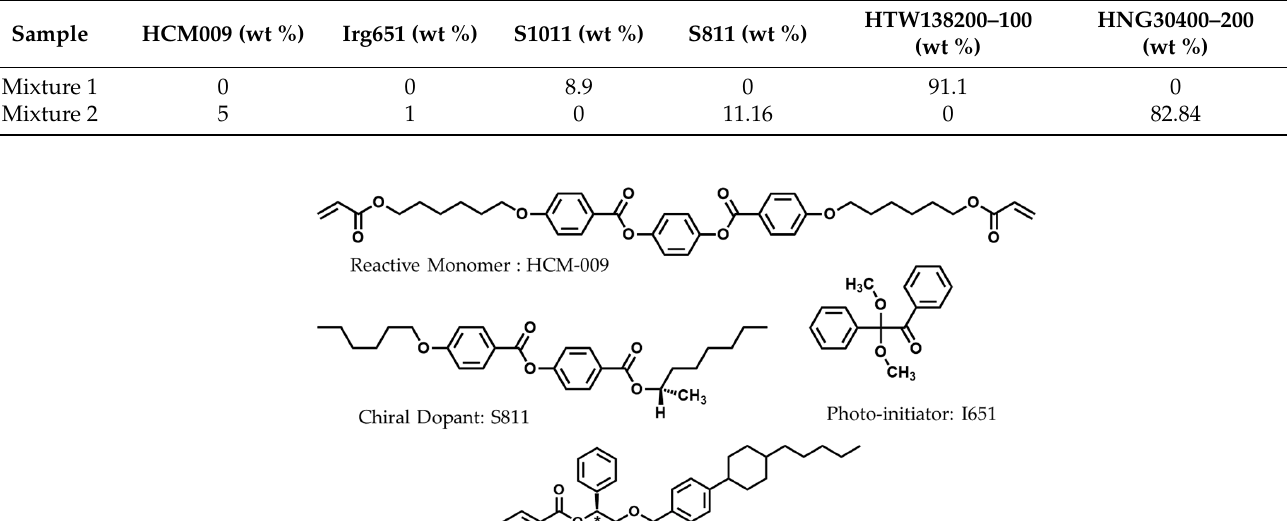
Table 1. The compositions of the samples